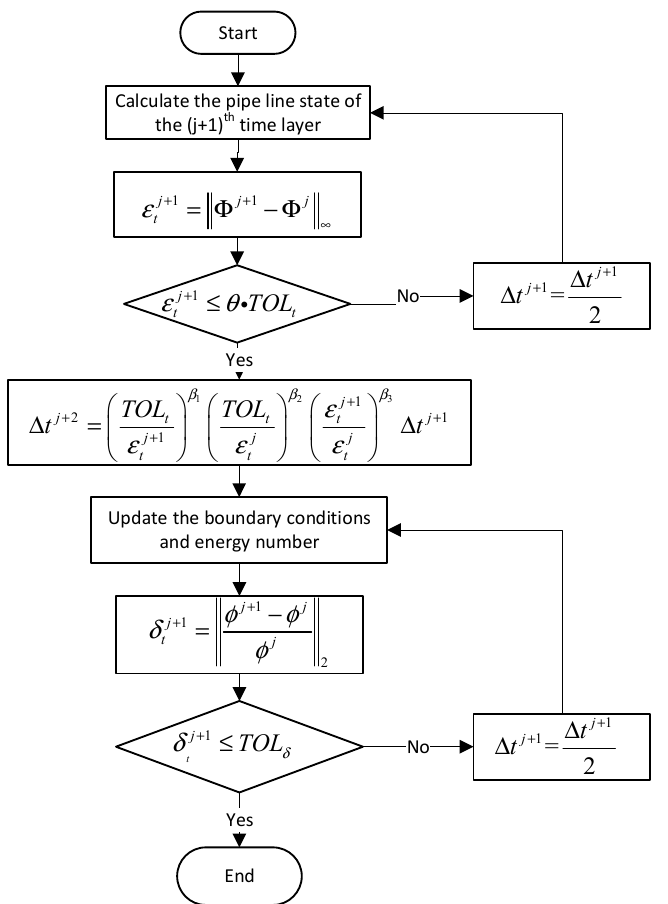
Figure 1. Steps of the improved adaptive time method.